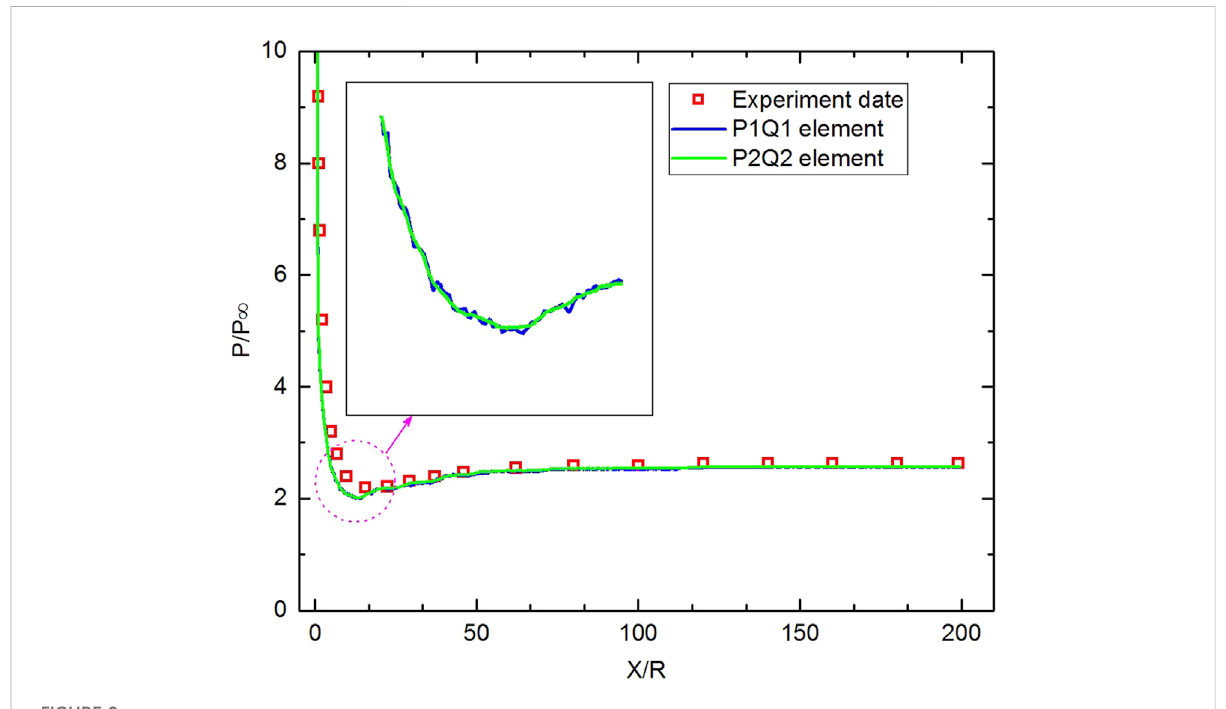
FIGURE 9 Comparison of the normalized pressure coef fi cient distributions with experimental data on the surface of blunt cone